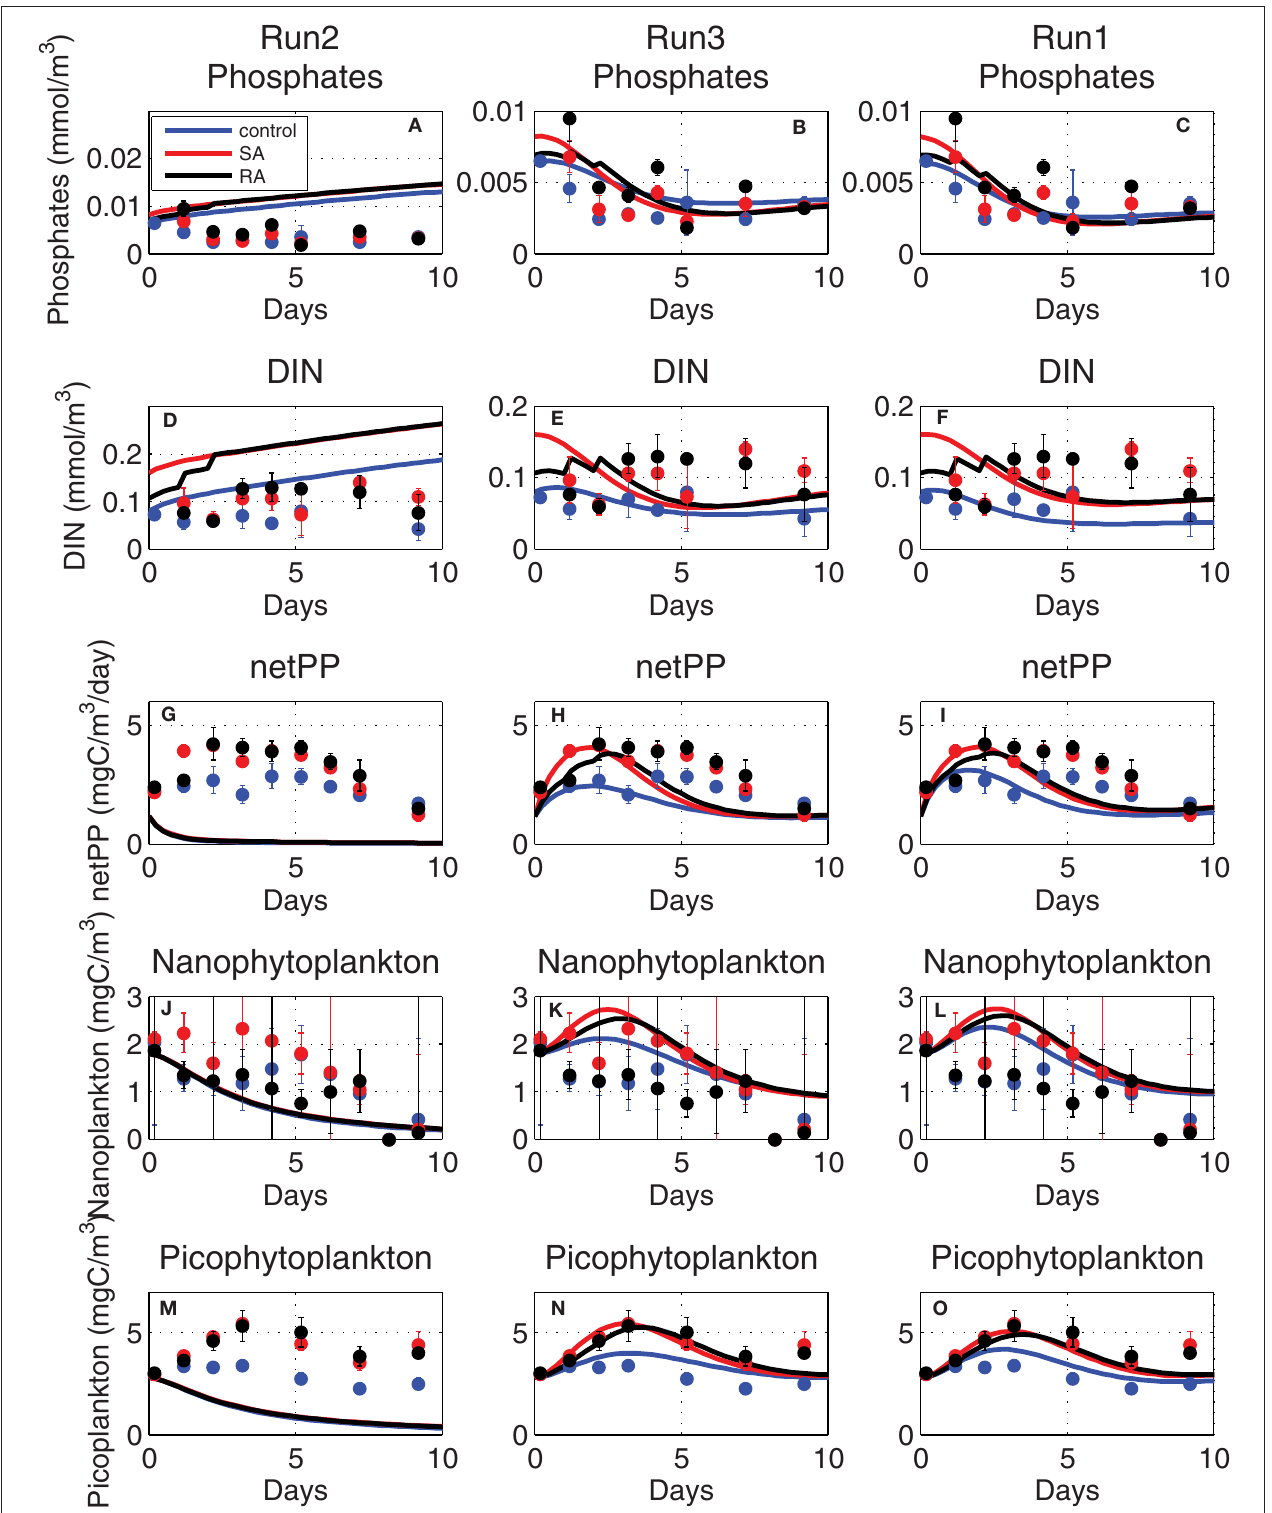
FIGURE 8 | Evolution of (A–C) phosphate (mmol/m 3 ), (D–F) dissolved inorganic nitrogen (DIN, mmol/m 3 ), (G–I) net primary production (netPP, mgC/m 3 /day), biomass of (J–L) nanophytoplankton (mgC/m 3 ) and (M–O) picophytoplankton (mgC/m 3 ), simulated adopting old phytoplankton affinity (Equation 1, Run2), higher (fitted) affinity (Equation 1, Run3), and with the Michaelis-Menten kinetics (Equation 7, Run1) adopted formulation (see Table 1 for simulations attributes).